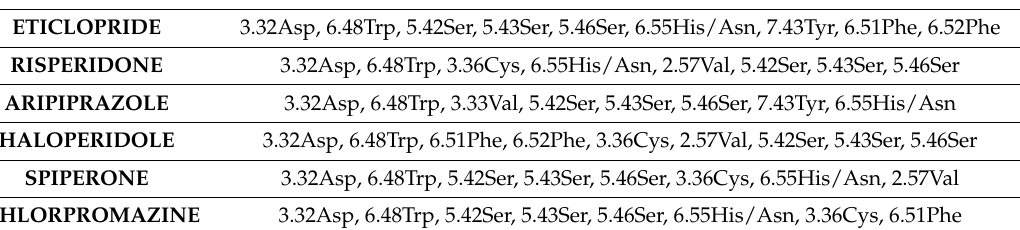
Table S3—Summary of the structures used in literature for defining the binding pocket for the D 2 R and source (experimental and computational); Table S4—Docking results for the D 1 R; Table S5—Docking results for the D 2 R; Table S6—Docking results for the D 3 R; Table S7—Docking results for the D 4 R; Table S8—Docking results for the D 5 R; Table S9—Docking results for the crystal structure templates of D 2 R (PDBid: 6CM4), D 3 R (PDBid: 3PBL) and D 4 R (PDBid: 5WIU) docked with their co-crystalized ligands; Table S10—D 1 R residues with Ballesteros & Weinstein-numbering participating in different interaction types sorted by ligands; Table S11—D 2 R residues with Ballesteros & Weinstein-numbering participating in different interaction types sorted by ligands; Table S12—D 3